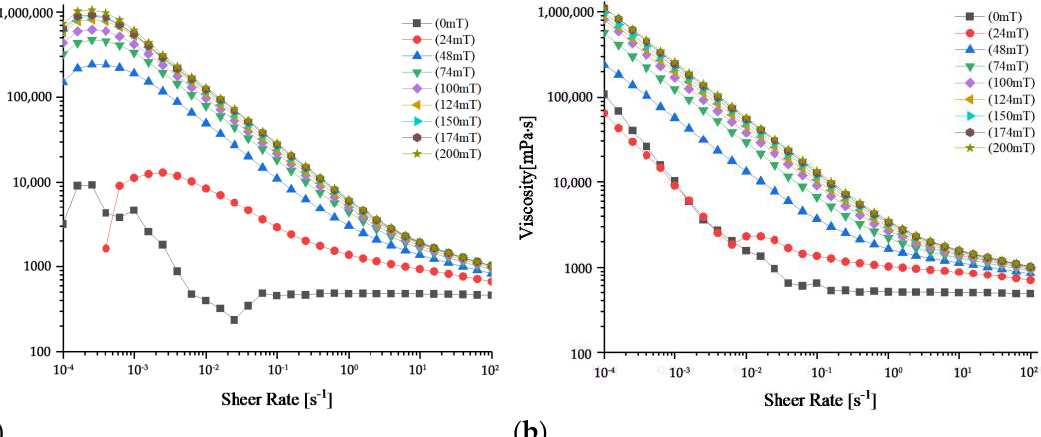
Figure 4. The viscosity of the FF in different initial states under different magnetic field strengths evolves with the shear rate: ( a ) Placed under the magnetic field for 600 s before the experiment; ( b ) 90 s pre-shear with a shear rate of 100 s −1 .